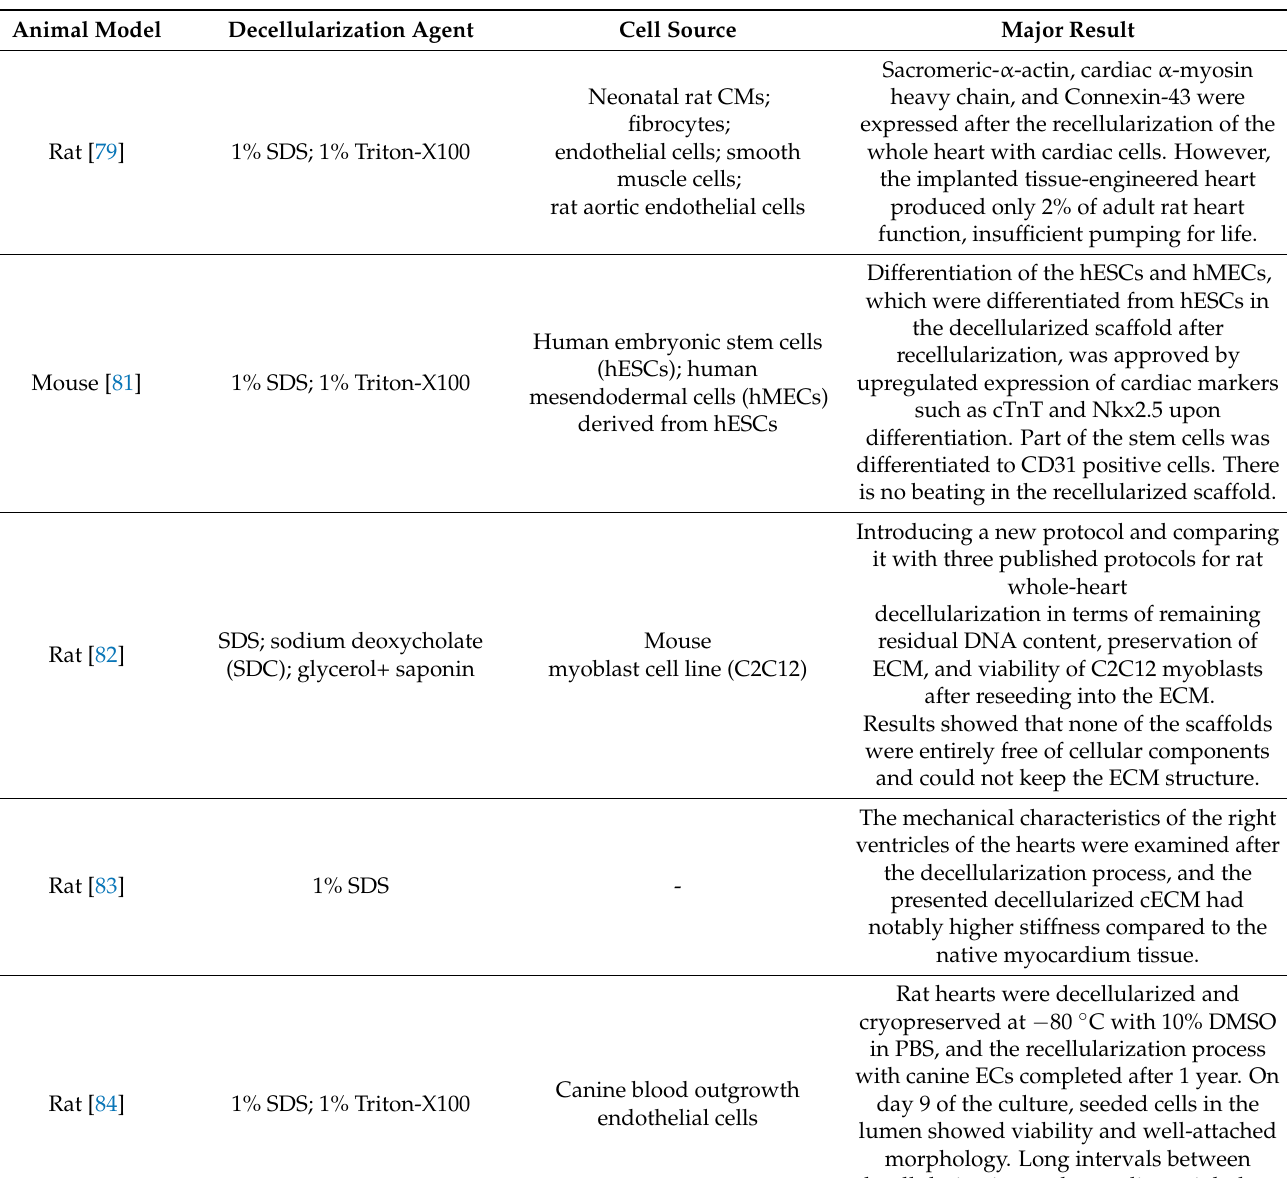
Table 1 summarizes the to-date efforts on rodent whole-heart decellularization. Table 1. Rodent whole-heart